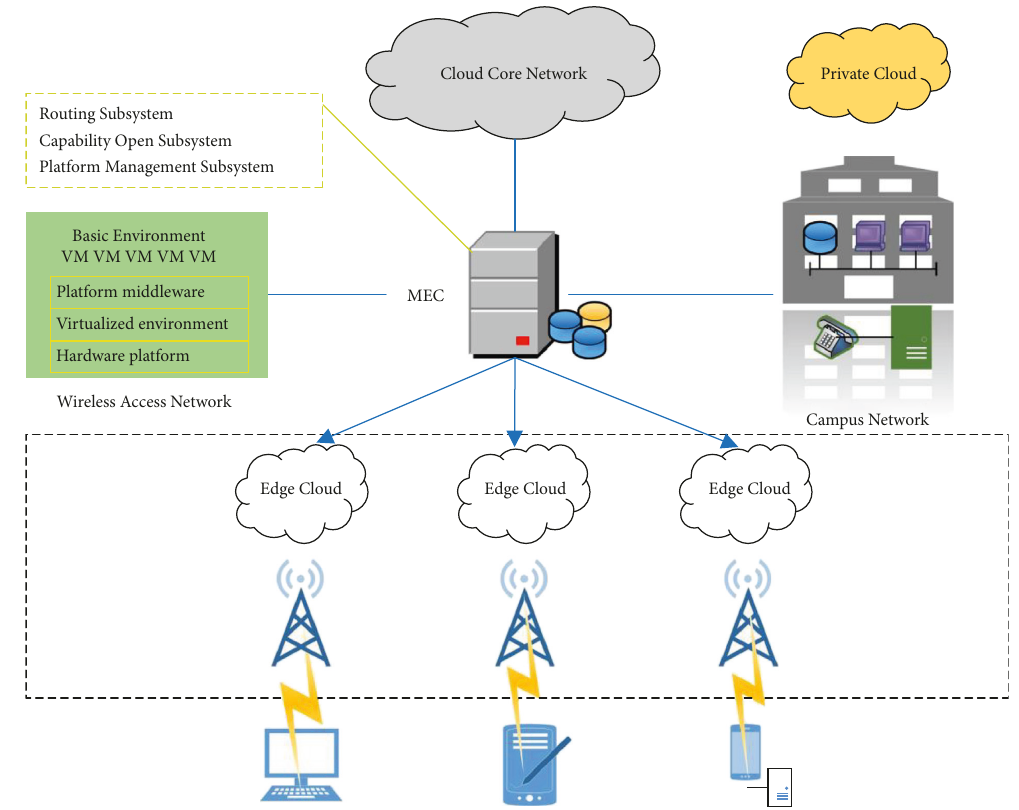
Figure 1: Integrated processing platform framework based on edge computing.